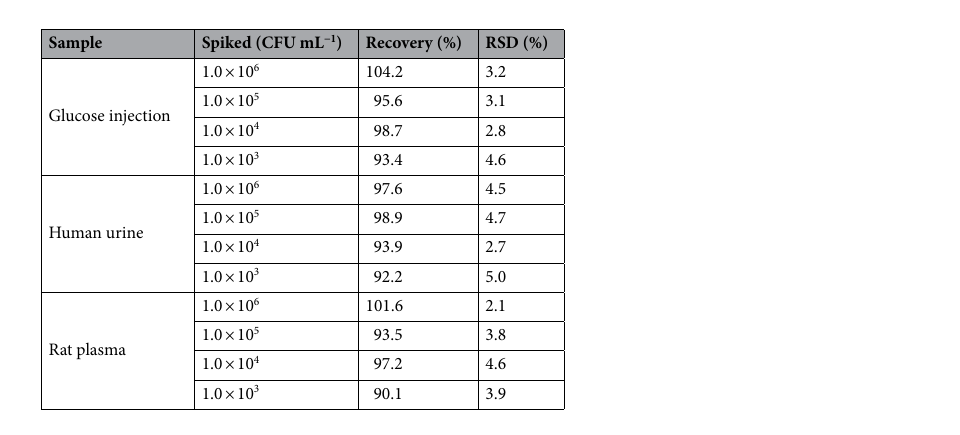
Table 1. Recovery tests for P. aeruginosa detection spiked in practical samples ( n = 4).